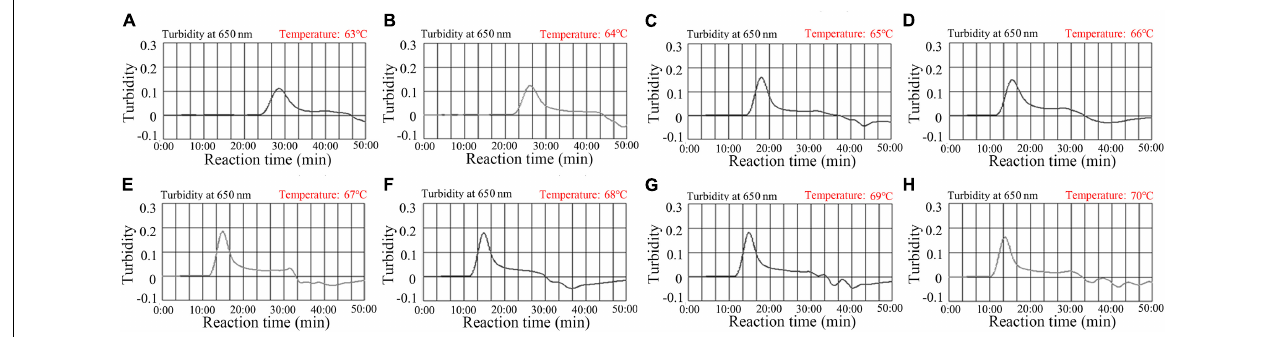
FIGURE 4 | Temperature optimization for N. gonorrhoeae- MCDA reactions. N. gonorrhoeae- MCDA reactions were monitored by real-time turbidity measurements (LA-500). Turbidity > 0.1 was considered positive, and the threshold value was 0.1. Eight kinetic graphs (A–H) were derived at various reaction temperatures; 63–70 ◦ C at 1 ◦ C intervals, with N. gonorrhoeae reference strain (ATCC 49926) target DNA at 2 × 10 3 copies/reaction. The optimal MCDA reaction temperature was selected based on higher turbidity. The temperature, 67 ◦ C (E) showed robust amplification.